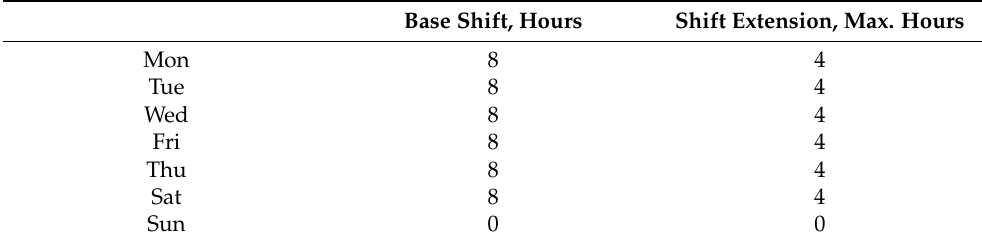
Table 1. Work shift arrangements of harvesters and forwarders for the working